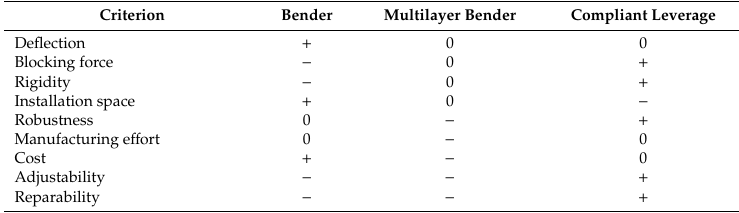
Table 1. Evaluation of various design concepts for the active